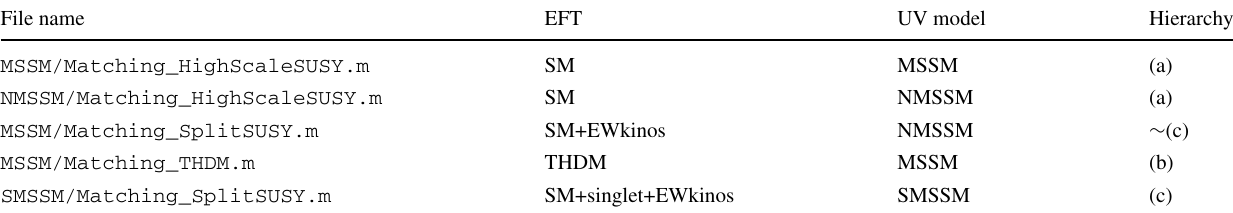
, d where the Yukawa couplings g u are as in the example of 1 , 2 Sect. 3.4.3, σ a are the pauli matrices and α = 1 , ..., 8. In order to calculate the Higgs boson mass in this model, the common approach is to (i) decouple the SUSY scalars at the scale M SUSY andcalculate λ SM ( M SUSY ) includingimportant higher-order corrections, (ii) run the split-SUSY RGEs to the scale M χ of the remaining SUSY states and calculate the shift in λ SM ( M χ ) , (iii) run the SM RGEs to m t and calculate m h ( m t ) at the two-loop level. The full results for the one- loop matching conditions at M SUSY and M χ were given in Ref. [10]. Also the dominant two-loop corrections to λ SM